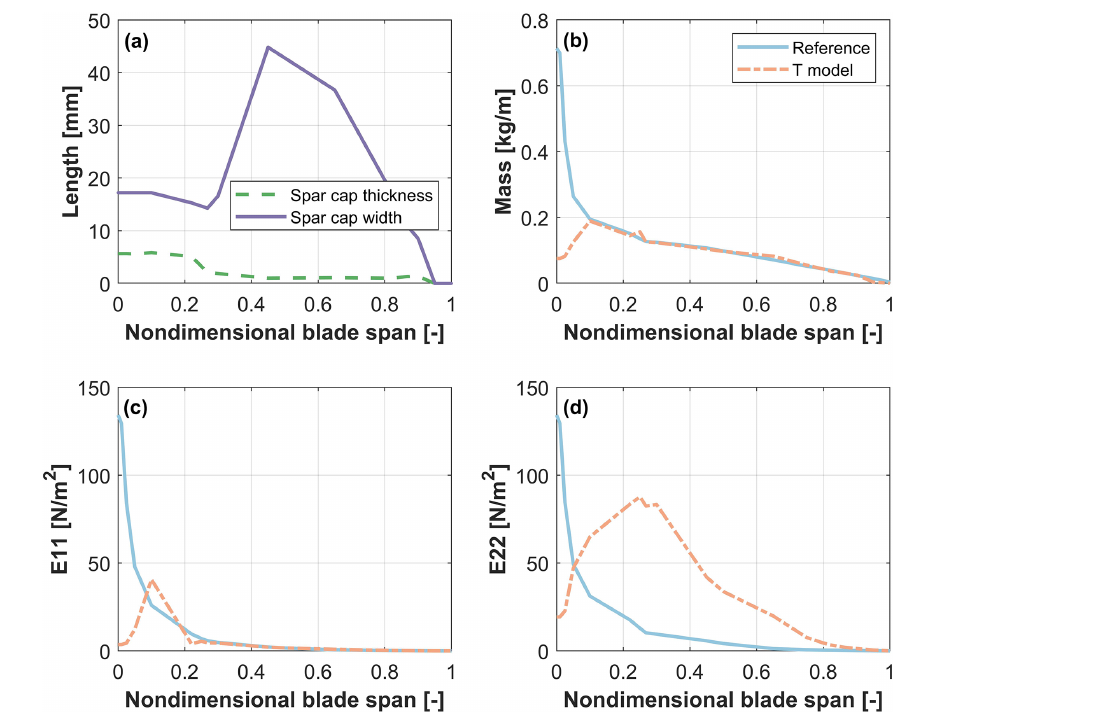
Figure 5. (a) Spar caps thickness and width, (b) mass distribution, (c) flapwise stiffness distribution, and (d) edgewise stiffness distribution for the T model. The label “reference” indicates the characteristics of the full-scale blade, subscaled to the T-model scale.